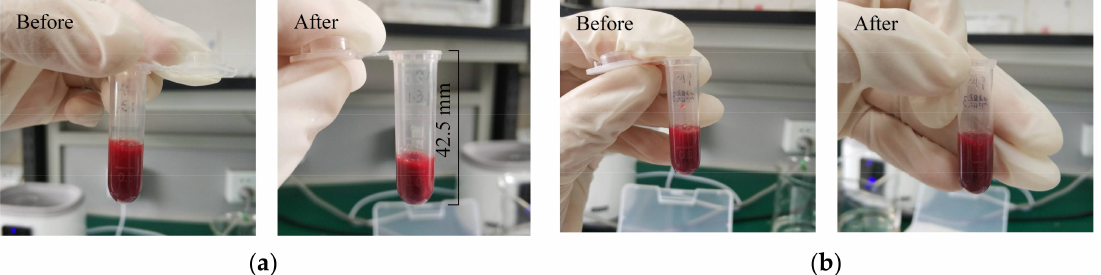
Figure 11. Initial in vitro test for MB-assisted local sonothrombolysis. ( a ) Clot mass reduction in an active group before and after treatment. ( b ) Clot mass reduction in the control group before and after